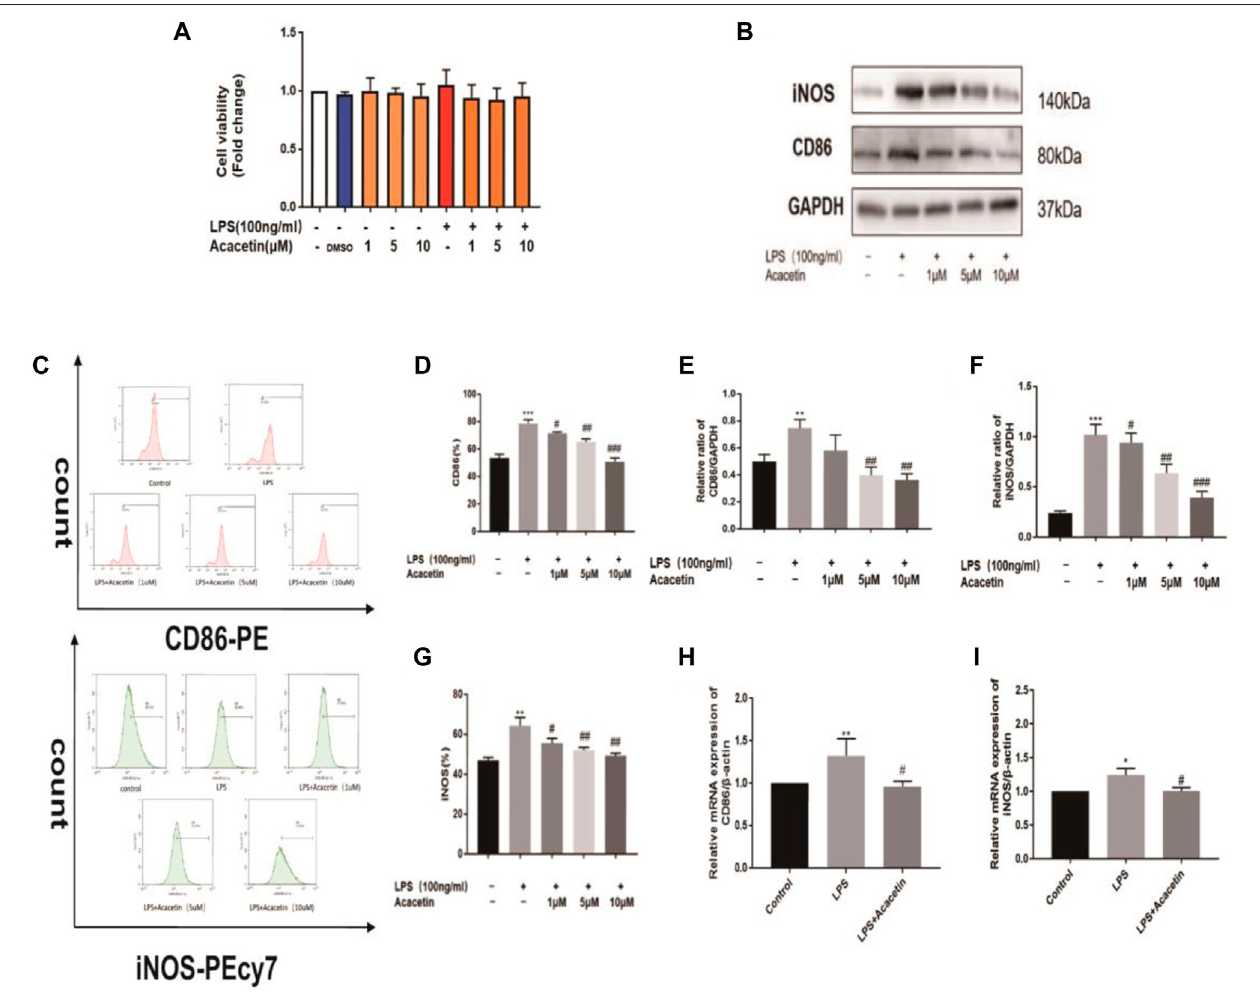
FIGURE2| Theprotectiveeffectofacacetinagainstsepsis invitro . (A) Theeffectofacacetinoncellviabilityasdetermined bytheMTTassay.Theproteinlevels (B, E, F) , positive cells identi fi ed by FACS (C, D, G) , and mRNA levels (H, I) of the M1 polarization markers CD86 and inducible nitric oxide synthase (iNOS) in RAW264.7 cells. The data are expressed as the mean ± SEM ( n (cid:1) 3). * p < 0.05, ** p < 0.01, and *** p < 0.001 compared with the control group; # p < 0.05, ## p < 0.01, ### p < 0.001 compared with the LPS-stimulated group.